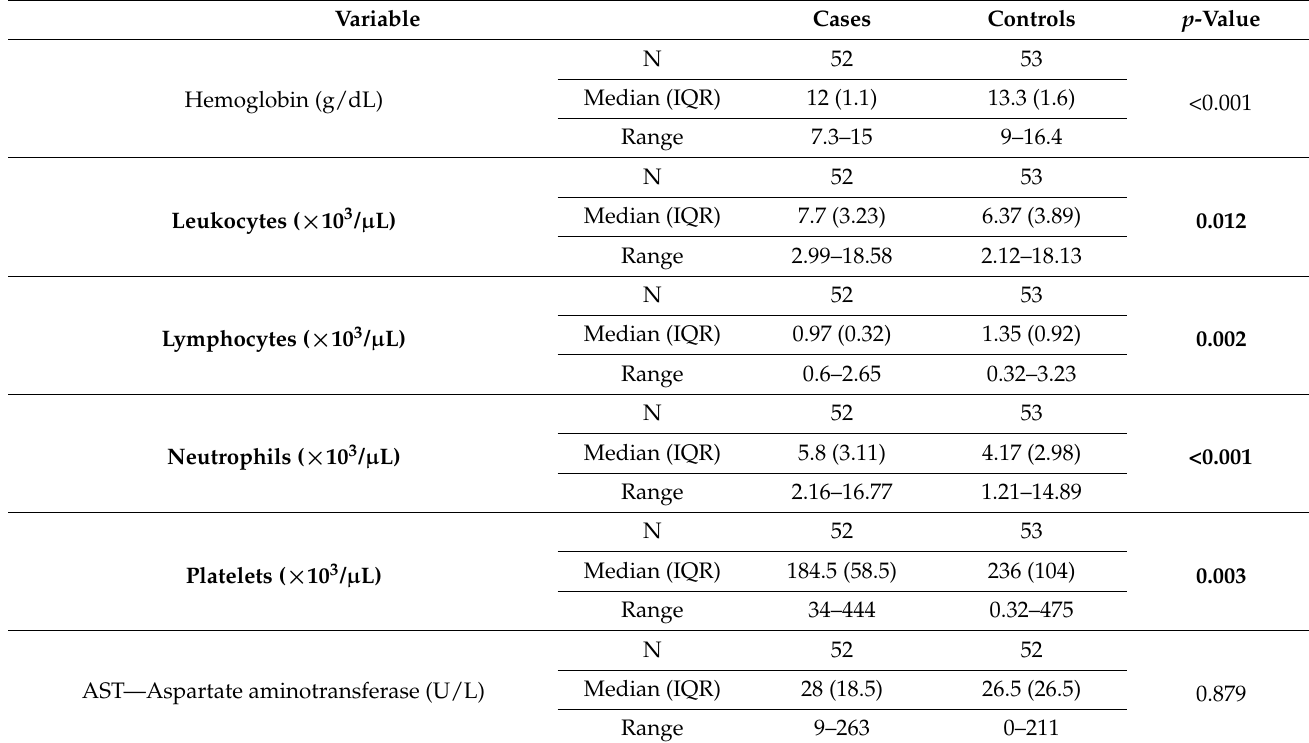
Table 7. Patients’ laboratory